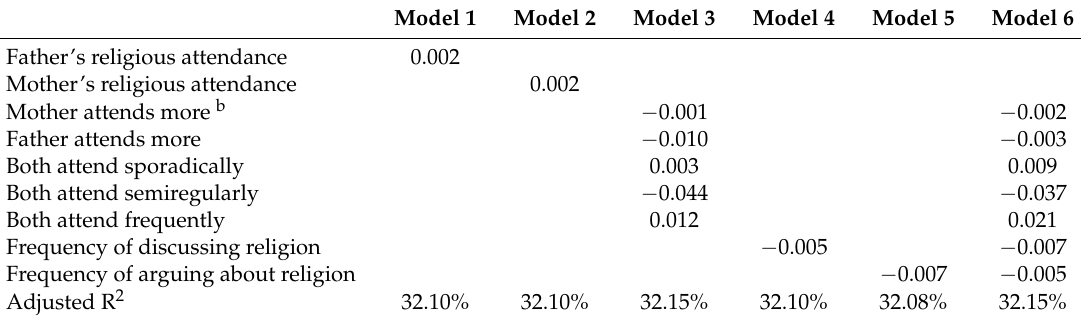
Table 5. Unstandardized coefficients predicting children’s externalizing problem behaviors (teachers’ ratings, n = 10,720) a